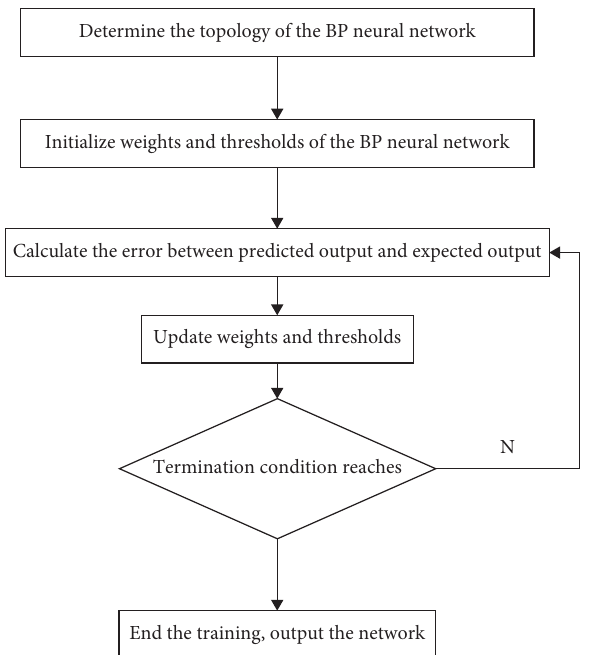
Figure 2: The flowchart of